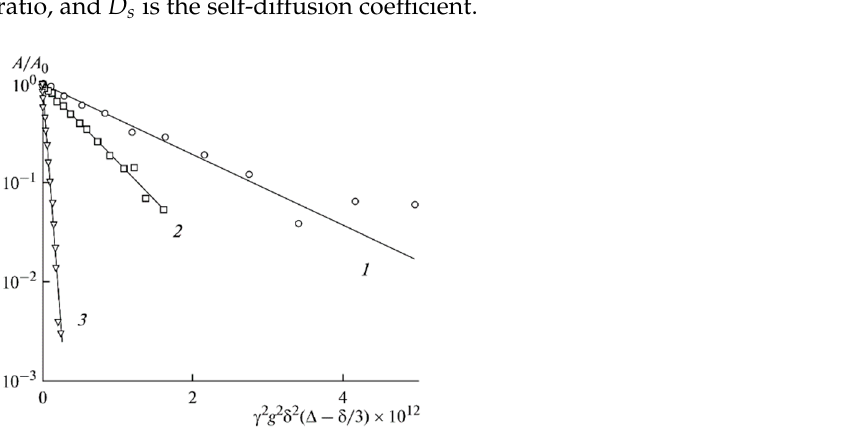
Figure 11. Example of 1 H diffusion decay in PGE sample no. 7 [53]. The ionic conductivities σ NMR were calculated from Li + self-diffusion coefficients us- ing the Nernst–Einstein Equation (3). 𝜎 (cid:3404) 𝑁𝑒 (cid:2870) 𝐷 𝑘𝑇 (3) where N is the number of Li + ions per unit volume, e is the electron elemental charge, k is the Boltzmann constant, T is the absolute temperature, and D Li+ is the Li + self-diffusion coefficient. Figure 12 shows the calculated conductivity σ NMR and experimental conductivity σ exp measured by the impedance spectroscopy dependences on ethylene carbonate content.